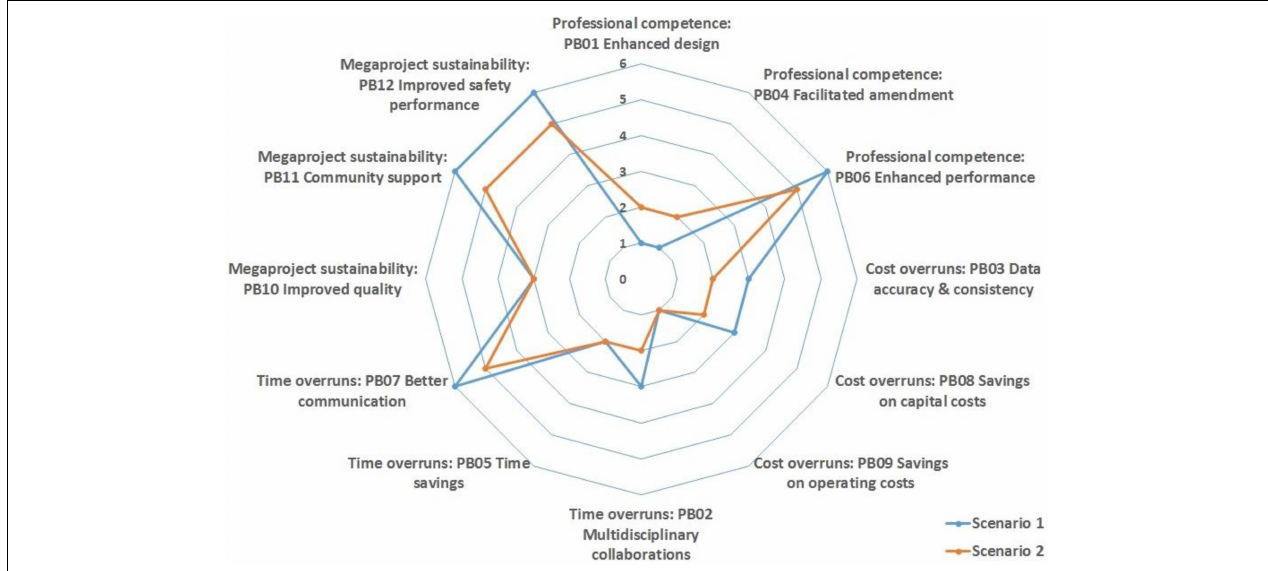
FIGURE 4 | BIM Value Compass for visualizing prioritized benefits among megaproject